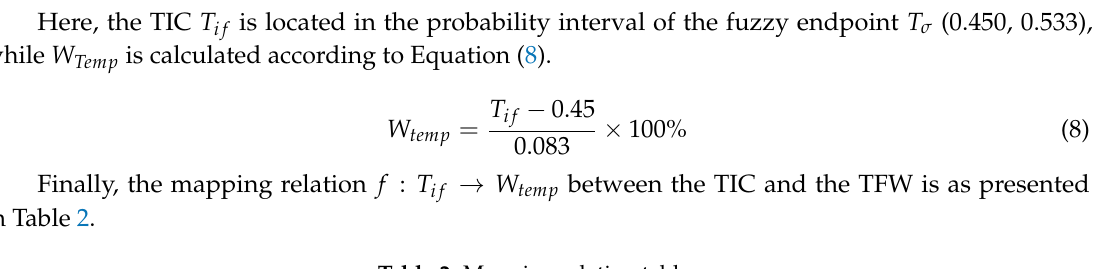
Table 2. Mapping relation